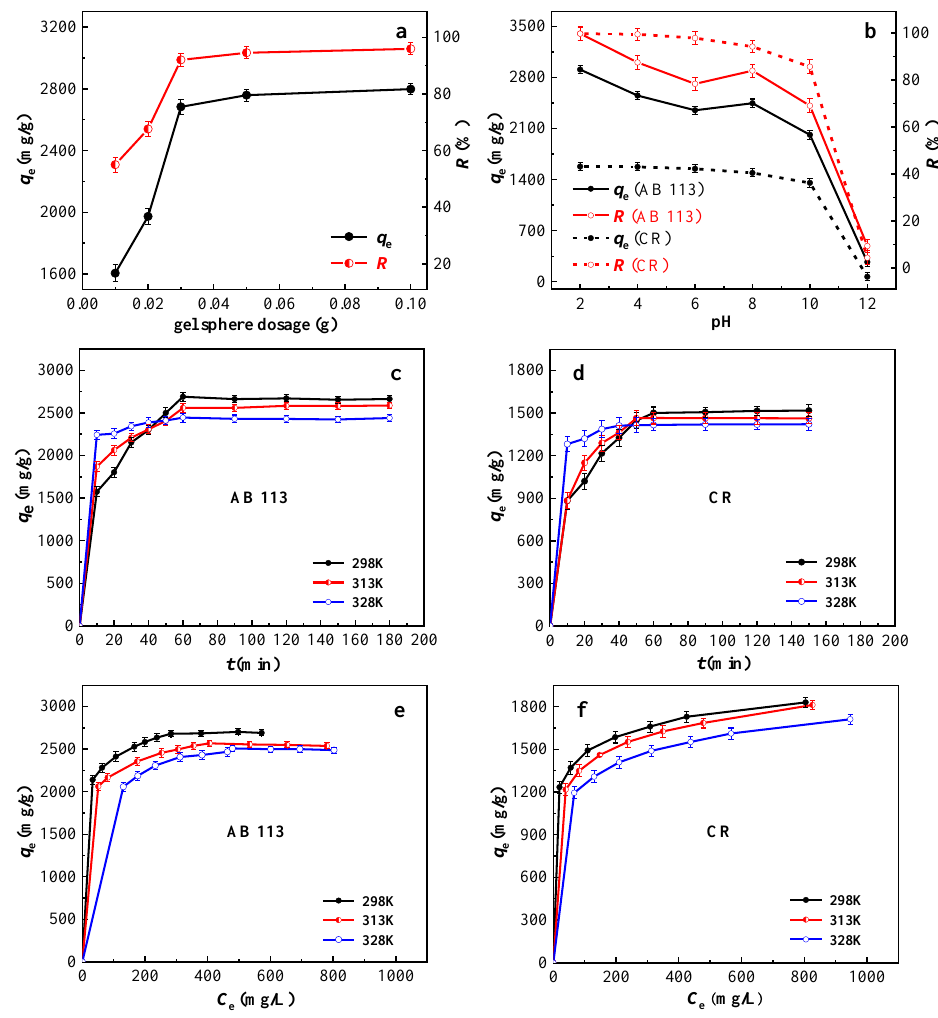
Figure 3. Effect of gel sphere dosage ( a ), pH ( b ), contact time and temperature on adsorption ( c, d ); Isothermal adsorption curves ( e, f ).